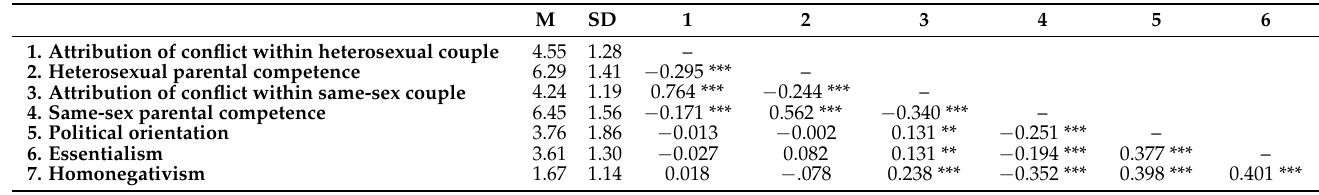
Table 1. Means, standard deviations, and correlations between the study